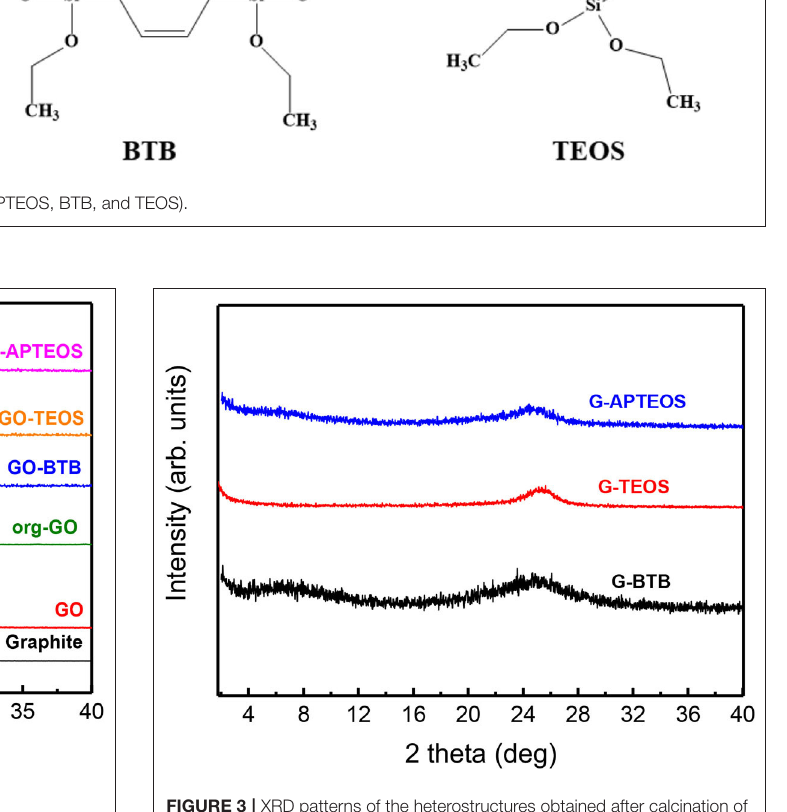
further purification. Distilled deionized water was used for all